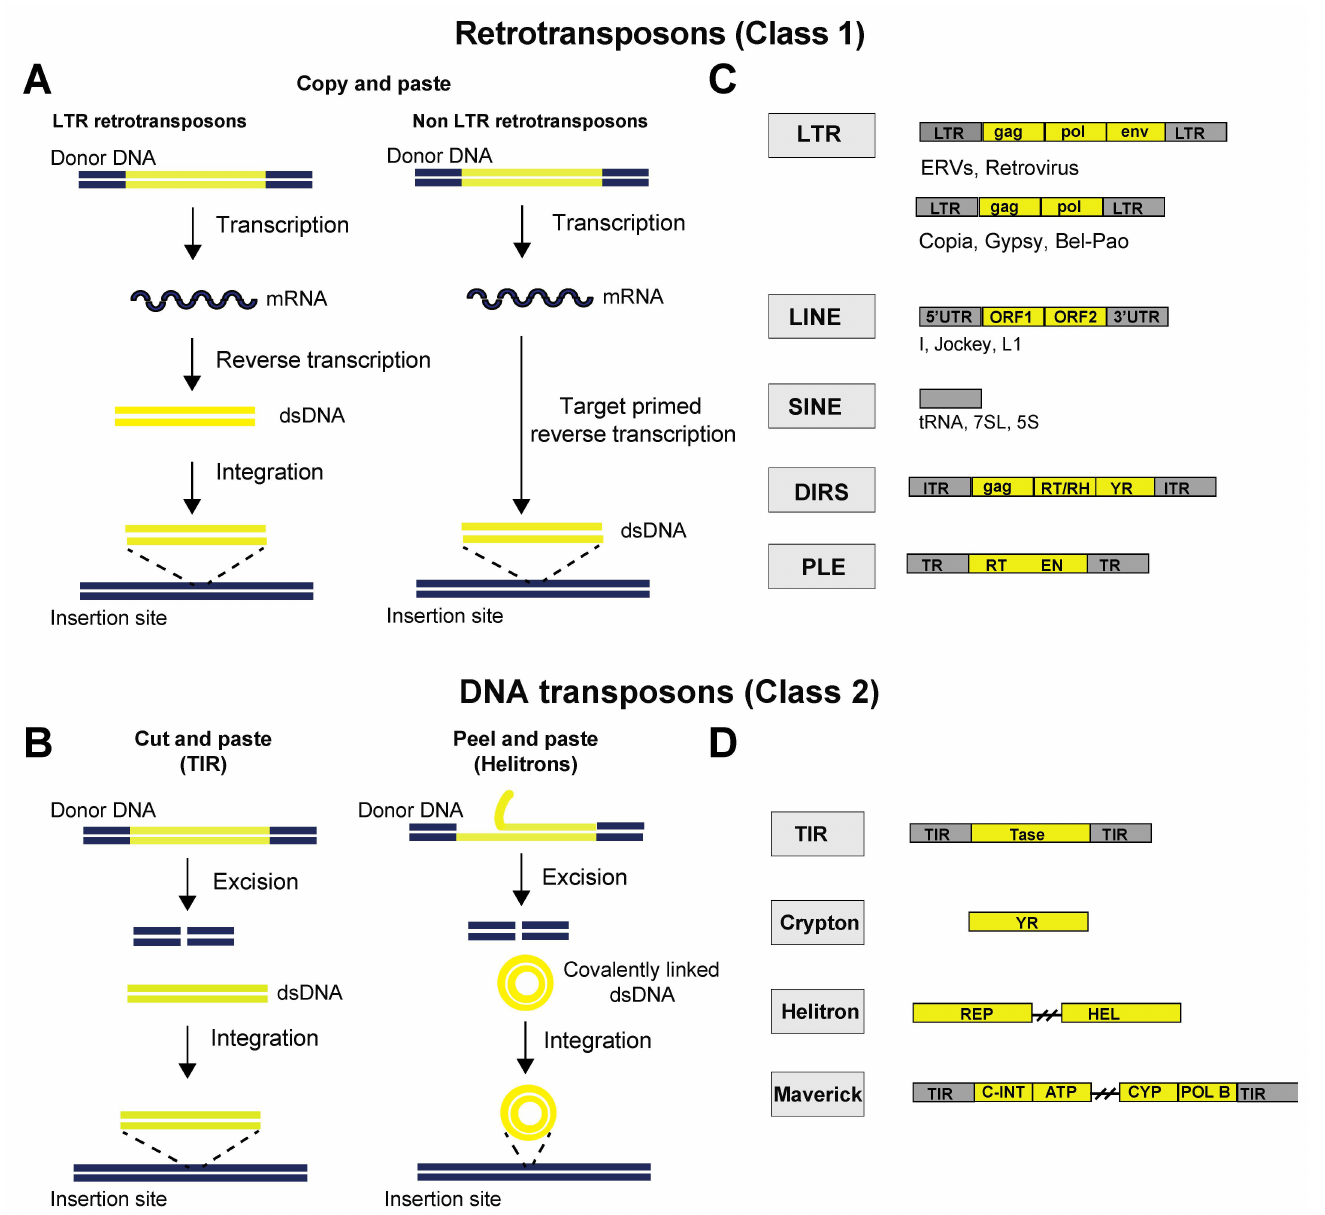
Figure 2. Schematic representation of the mobilization mechanisms of transposable elements. ( A ) Schematic representation of the “copy-and-paste” mobilization mechanism of